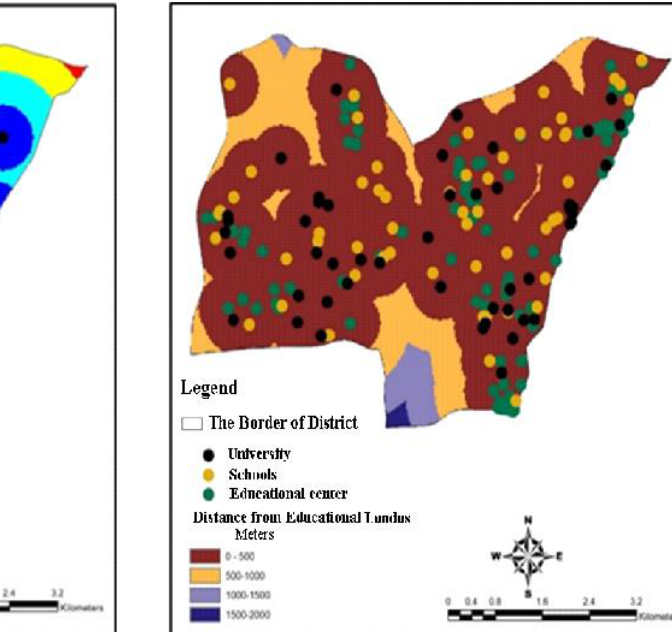
Fig. 10: The distance from Military centers